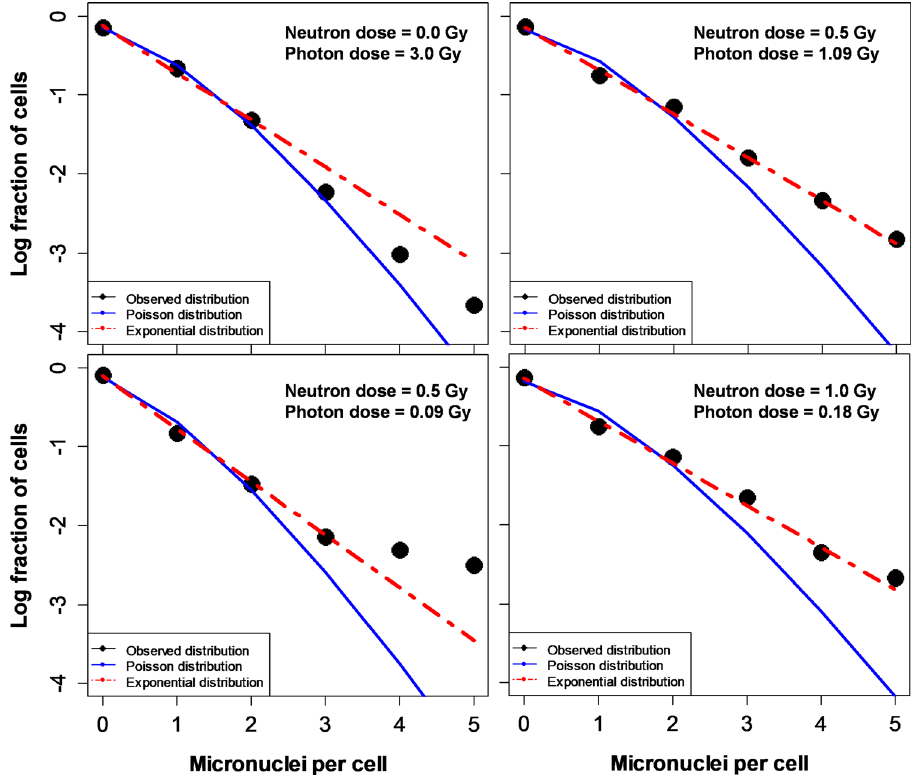
Figure 2. Comparison of some real data examples from our data set with the Poisson and Exponential distributions. These examples show the tendency of the data to deviate away from the Poisson distribution and to approach an Exponential distribution in blood samples exposed to substantial neutron doses. In contrast, data from samples exposed to photons only tend to be closer to the Poisson